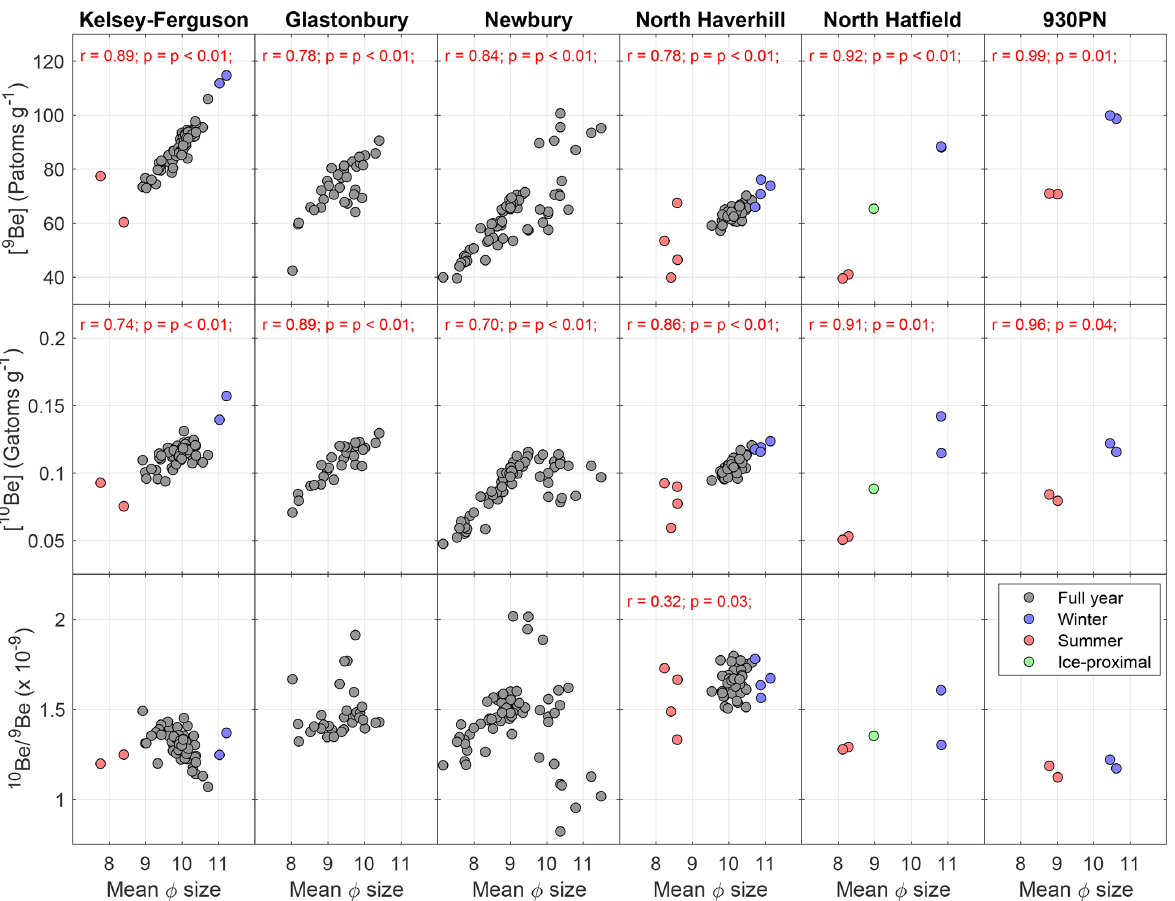
Figure 10. Correlation analysis for grain size and Be isotope concentrations and ratio. The correlation coefficient and p value are shown in red when data are correlated at 95% or better confidence. 9 Be and 10 Be concentrations are always significantly correlated with mean grain size. However, the 10 Be / 9 Be ratio is not. Note that (cid:56) size is inverse to dimensional grain size, so a positive correlation between Be concentration and (cid:56) is a negative correlation between Be concentration and grain